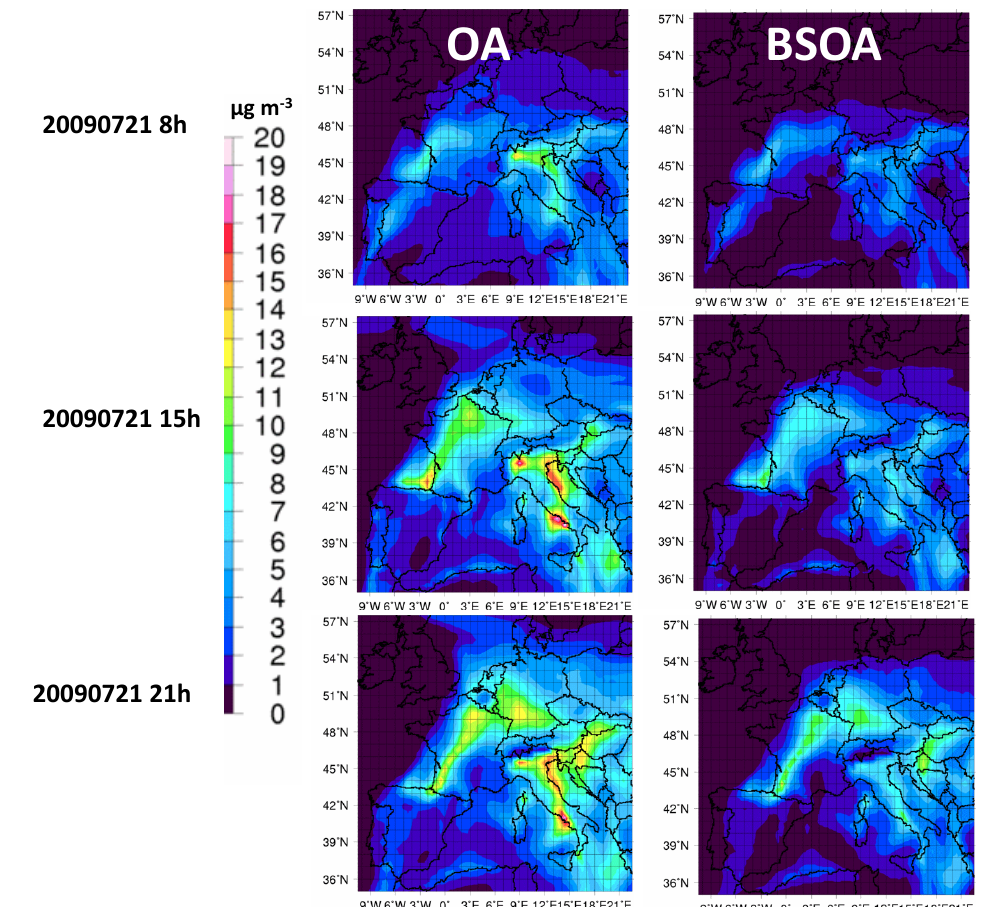
Fig. 11. Spatial OPOA, ASOA and BSOA distributions at surface level on 21 July; OA (left), BSOA (right).